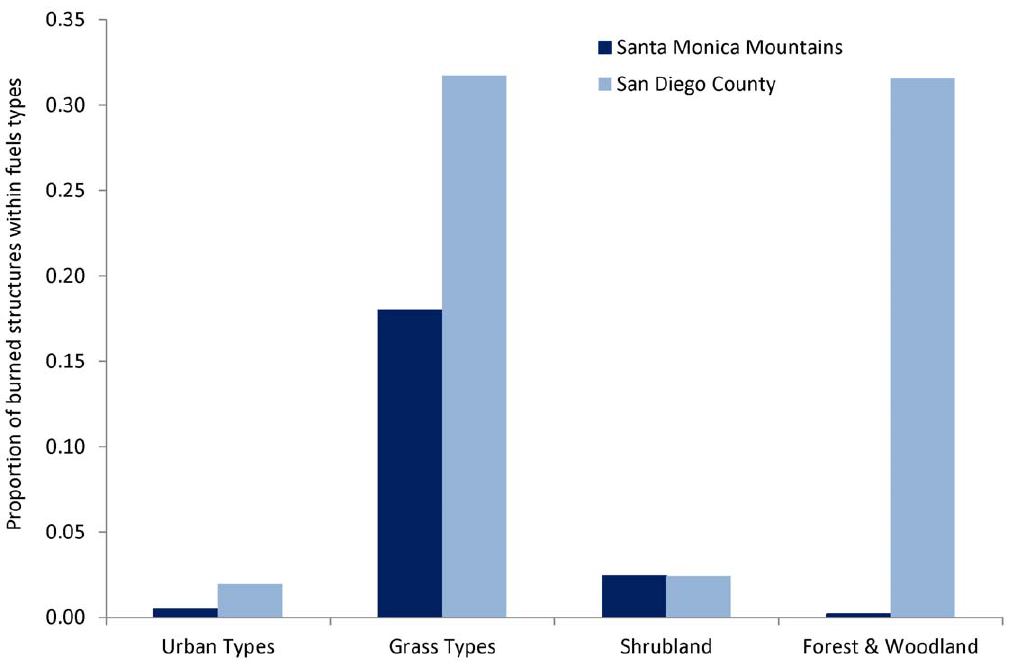
Figure 4. Proportion of burned structures within broad fuels types in the Santa Monica Mountains and San Diego County.